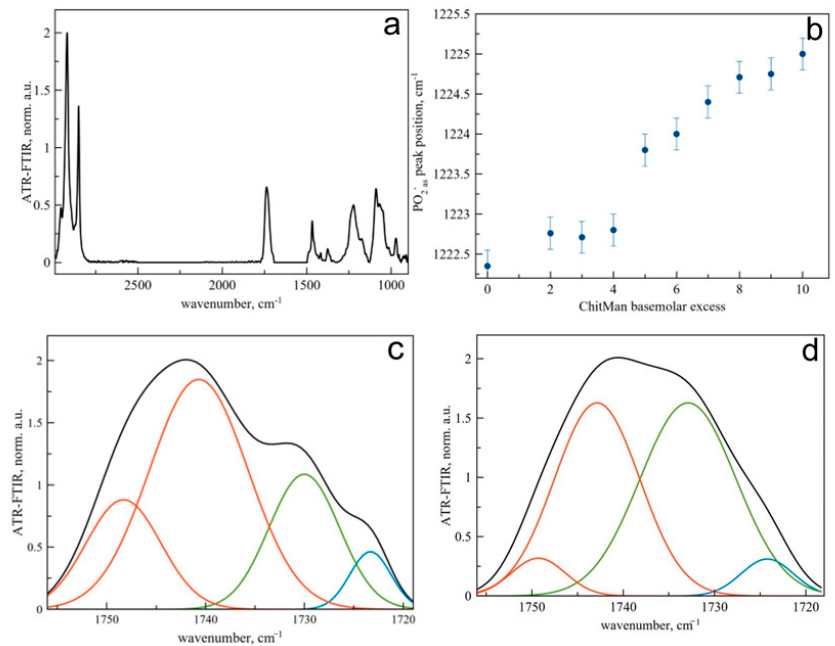
Figure 4. ( a ) Typical ATR-FTIR spectrum of liposomes DPPC:CL 80:20 (weight %). ( b ) Dependance of ν PO2 − as peak position on the base-molar excess of ChitMan for DPPC:CL 80:20 (weight %) SD, n = 3. ( c , d ) ATR-FTIR spectra of liposomes DPPC:CL 80:20 (weight %) and its complex with ChitMan (base-molar excess 5): carbonyl group area. Deconvolution was conducted with Gaussian function. Black line is initial spectrum, red line is component of low hydrated carbonyl groups, green line is component of moderately hydrated carbonyl groups and blue line is component of high hydrated carbonyl groups. 0.02 M Na-phosphate buffer solution, pH 7.4, 22 ° С . Polymer spectrum was subtracted as a background in ( a ) proper concentration of ( b – d ).